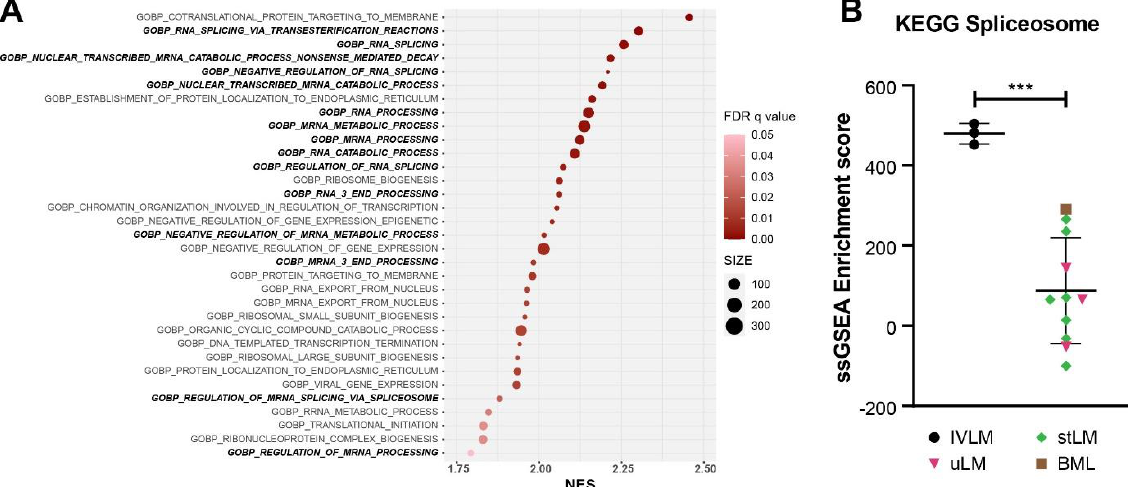
Figure 3. ( A ) Plot of Gene Set Enrichment Analysis (GSEA) results showing all the gene sets that are significantly enriched in IVLM samples. FDR q-value is represented by the colour of the circles while the size of the circles represents number of identified genes within each gene set. NES: normalized enrichment score. ( B ) Plot of single sample GSEA scores for the spliceosome gene set as defined by KEGG. The line and whiskers in plots represent mean and standard deviation. Statistical significance was calculated by a two-sample t -test. *** p < 0.001.